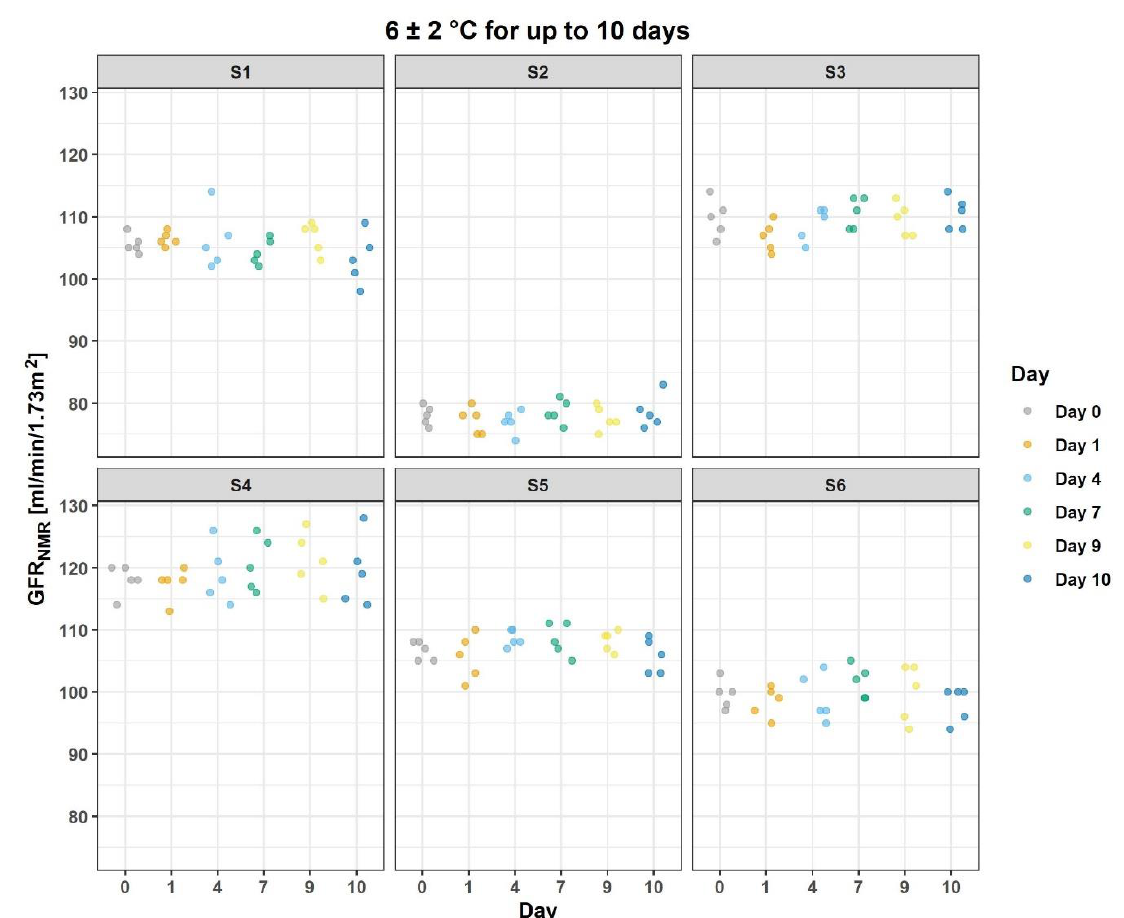
Figure 3. Scatterplot of GFR NMR stability upon on-board storage at 6 ± 2°C of NMR samples for up